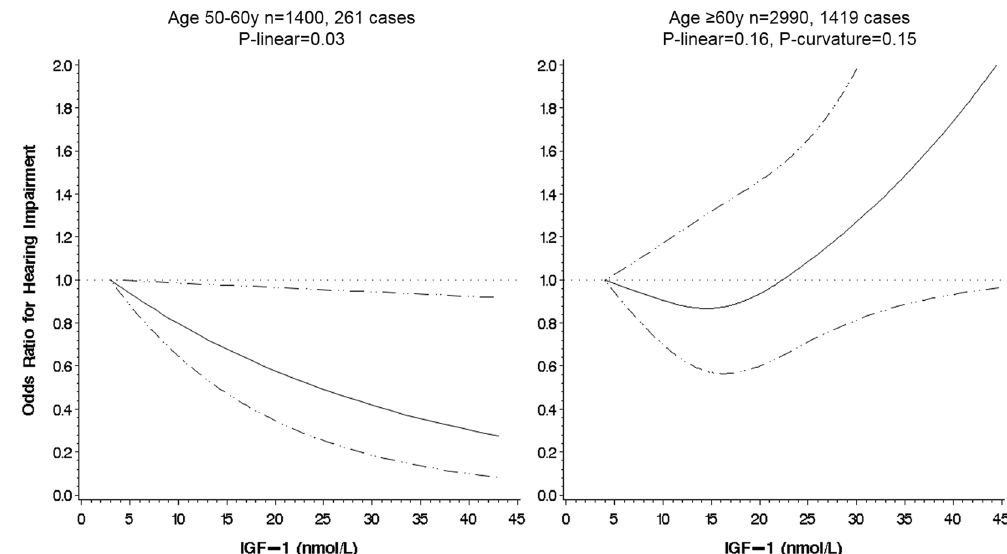
Figure 2. Serum Insulin-like Growth Factor-1 and odds of hearing impairment, by age group, the English Longitudinal Study of Ageing. Association estimated by logistic regression based on restricted cubic splines, the reference value is the minimum. Dashed lines indicate the 95% CIs. The model was adjusted for age, sex, height, smoking status, BMI, cognitive function (baseline and change), educational level, physical activity, self-rated poor health (baseline and change), and self-rated hearing acuity at